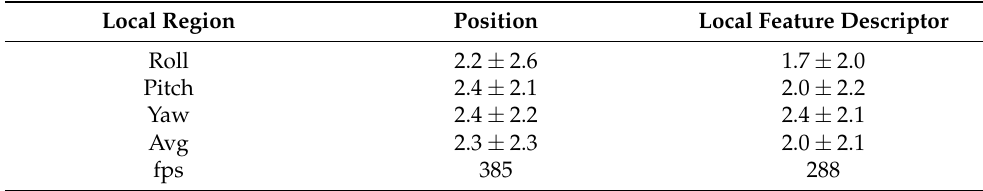
Table 1. Performance evaluation with different local region expressions on the Biwi Kinect Head Pose dataset.